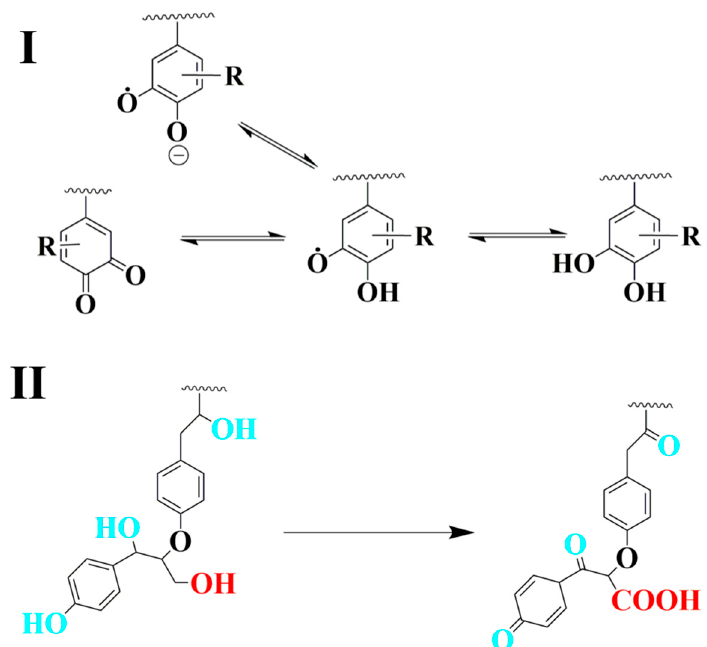
Figure 9. Proposed mechanism for the preparation of gold nanoparticles: ( I ) quinone related reduction mechanism, ( II ) hydroxyl groups related reduction mechanism.